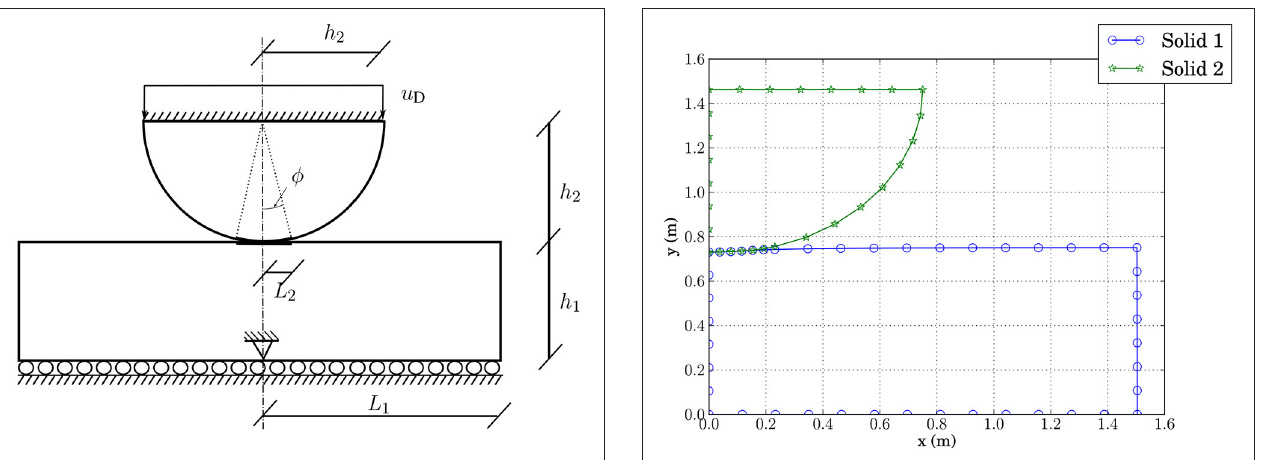
FIGURE 14 | A half elastic cylinder on an elastic rectangle. TABLE 5 | Geometry, elastic properties and imposed displacements.